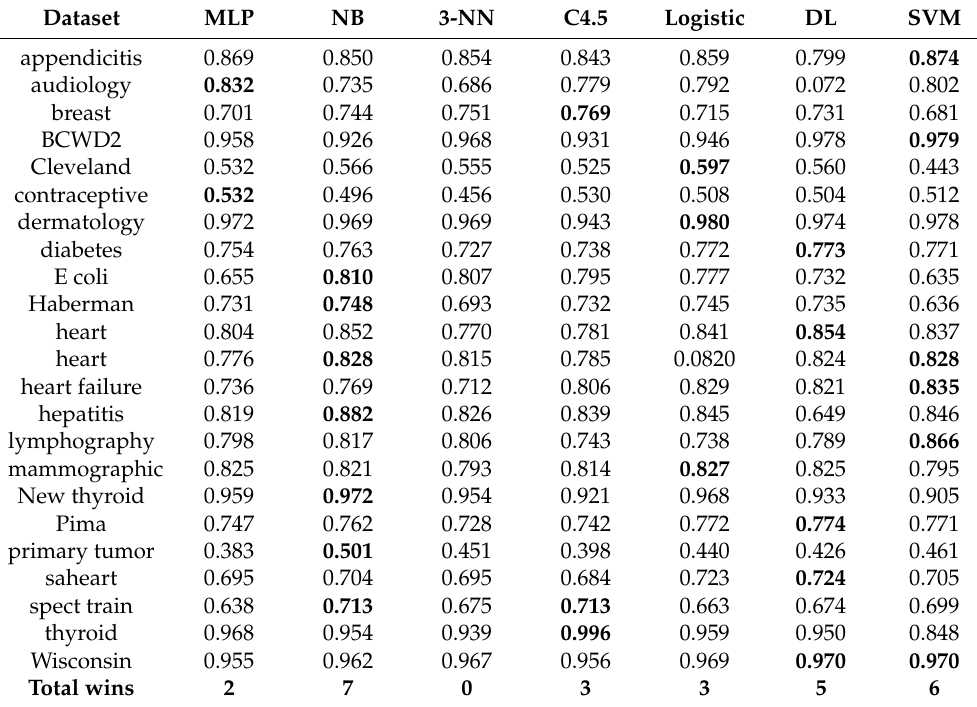
Table 4. Performance of the classifiers using Balanced Accuracy as a metric.